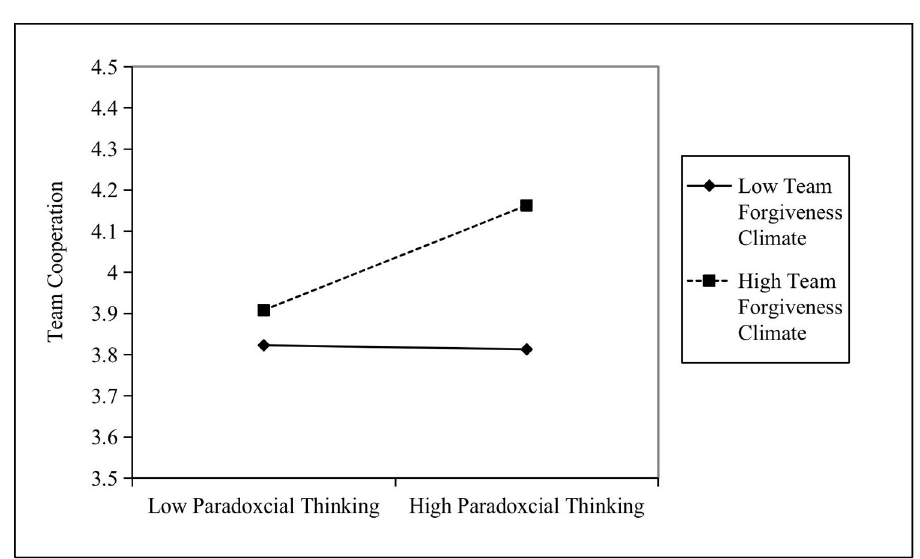
Fig 2. The impact of the interaction between paradoxical thinking and forgiveness climate on team cooperation.